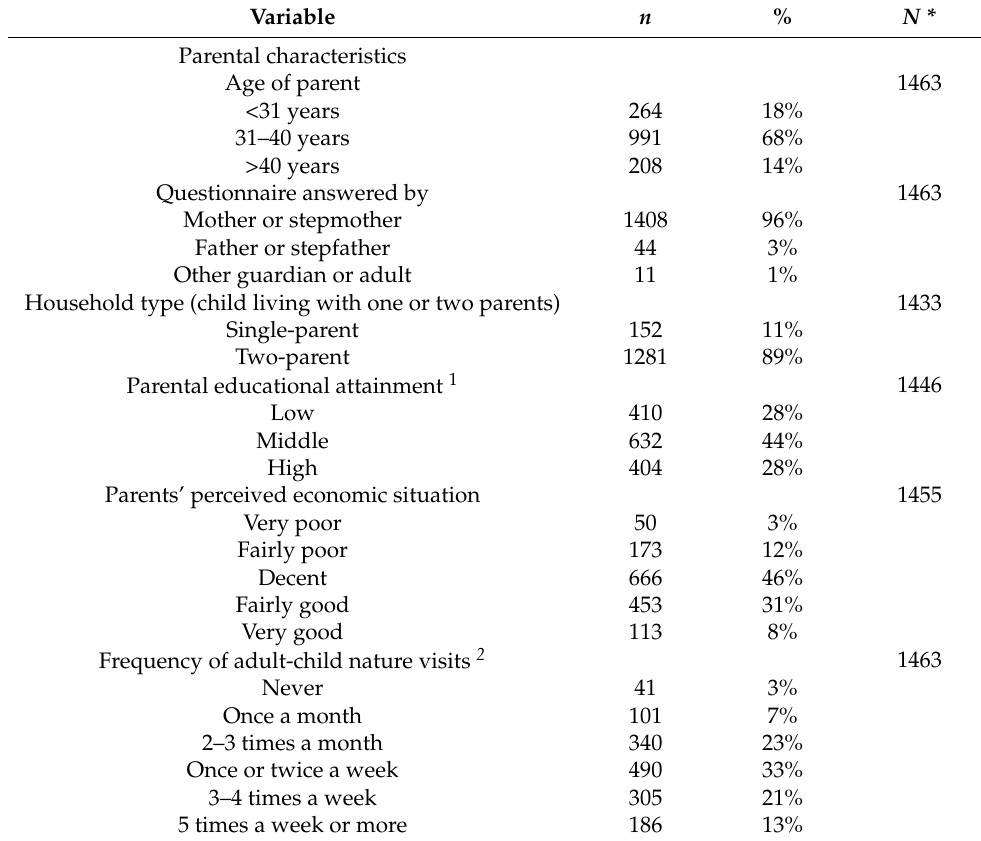
Table 1. Descriptive statistics for demographics of parents and frequency of adult-child nature visits. Variable n % N * Parental